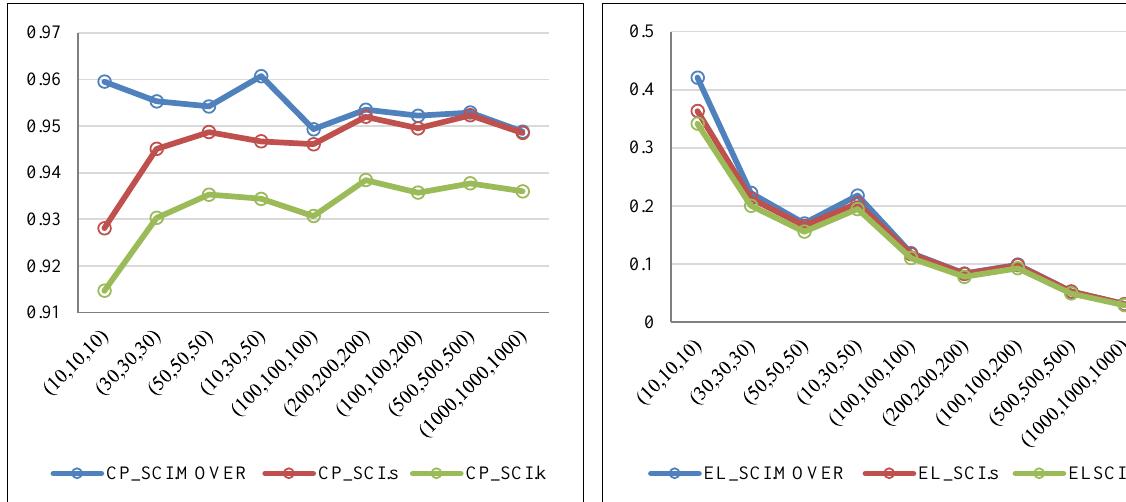
Figure 2. The CP and the EL of the 95% two-sided SCIs for the means of normal distributions with known CVs: (𝝉 ) = (0.1,0.2,0.3), 3 sample cases (𝒏 𝟏 , 𝝉 𝟐 , 𝝉 𝟑